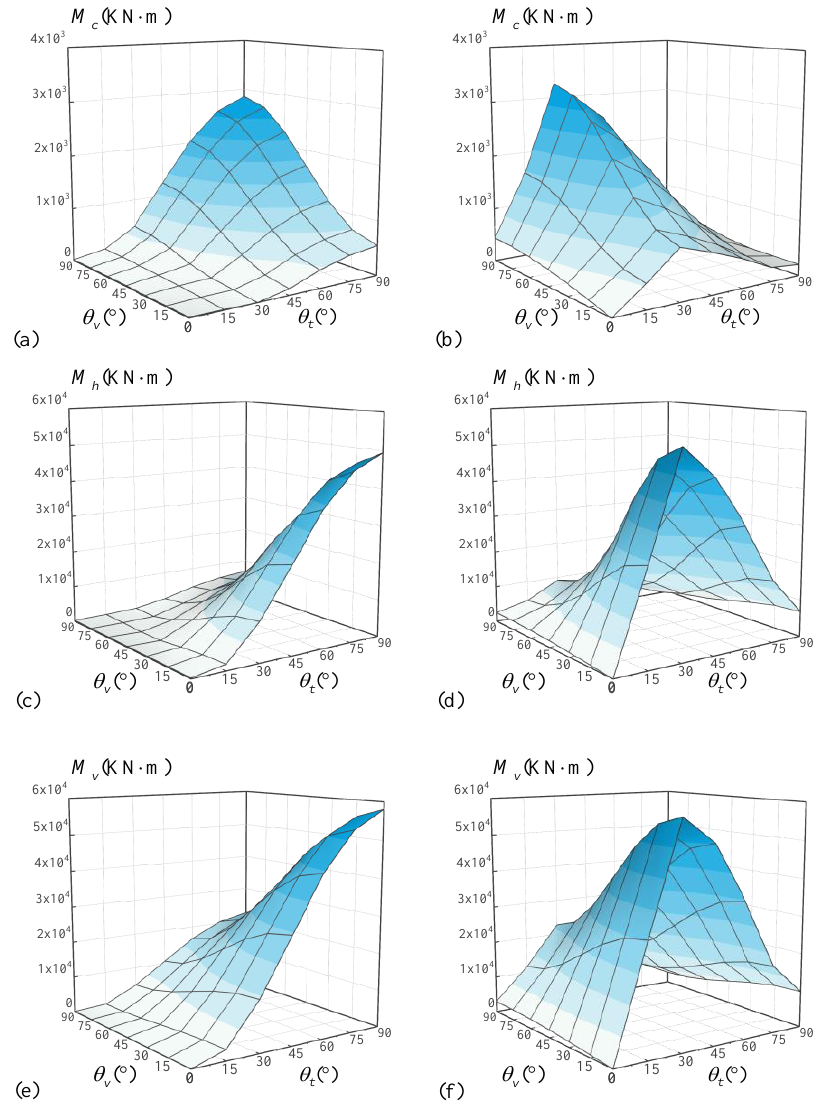
Figure 12. Schematic diagram of lining axial force, shear force and bending moment.